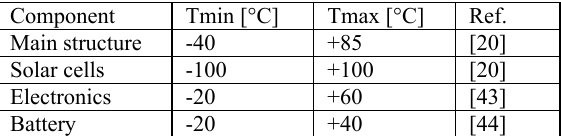
Table 4 Operating temperature ranges for satellite elements